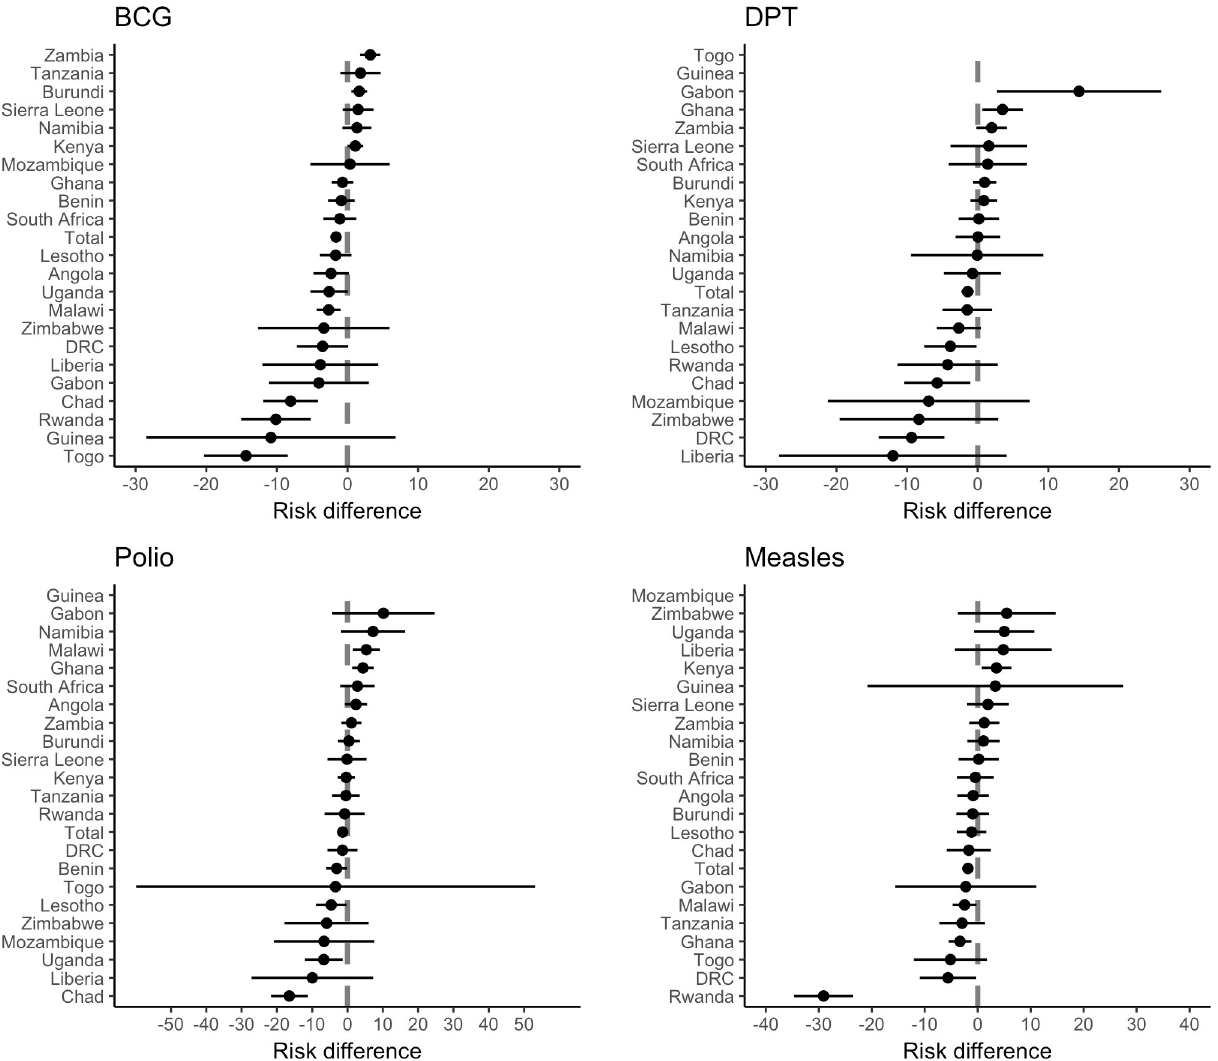
Fig 2. Country-specific adjusted associations between drought and vaccination. (A) BCG vaccination; (B) 3 doses of DPT vaccination; (C) 3 doses of polio vaccination; (D) measles vaccination. Models are adjusted for child sex, birth month, and birth order; mother’s age (15–19, 20–29, 30–39, or 40–49 years), mother’s literacy (literate versus not literate), mother’s education, and mother’s marital status; and household wealth index (quintiles), household size, and urban residence. Standard errors are clustered at the enumeration area level. Associations are presented as marginal risk differences in percentage points and 95% confidence intervals. Results are not shown for countries with insufficient variation in exposure/outcome data. BCG, Bacillus Calmette–Gue´rin; DPT, diphtheria–pertussis–tetanus; DRC, Democratic Republic of the Congo.